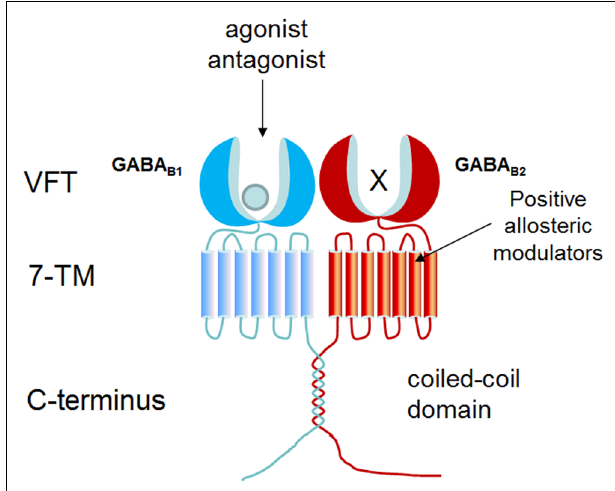
FIGURE 1 | Structure organization of GABA B receptor. GABA B receptor forms heterodimer composed by GABA B1 and GABA B2 . GABA B1 is responsible for ligand binding in N-terminalVFT domain, whereas theVFT of GABA B2 fails to bind any known ligand. PAMs bind to GABA B2 transmembrane domain to potentiate the effect of